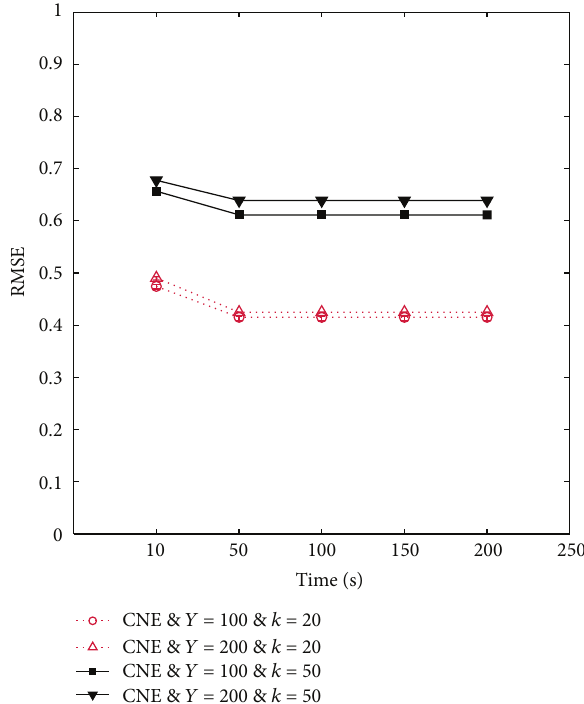
Figure 9: Variations of the link estimation errors in the CNE protocol with 1 beacon/second beaconing rate versus network initialization duration in multihop topology networks deployed in outdoor